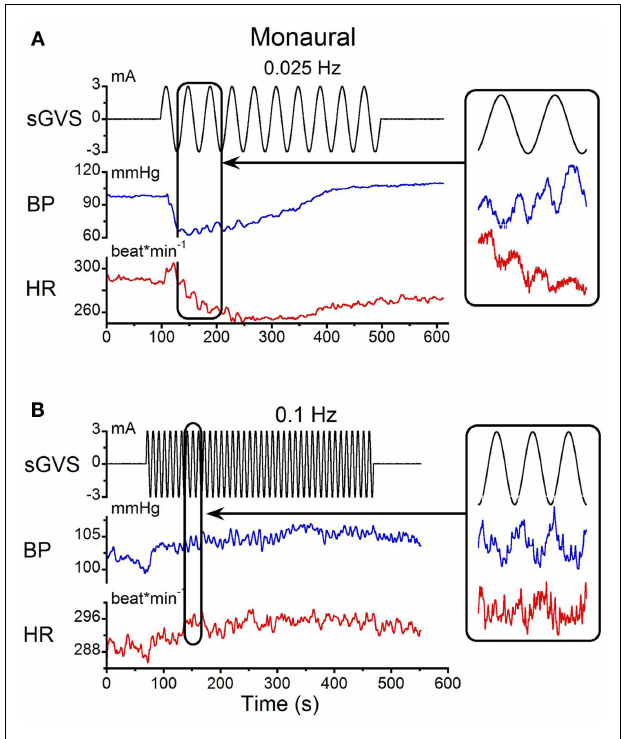
FIGURE 2 | Monaural sGVS induced by 3mA sinusoid at 0.025Hz (A) and 0.1Hz (B) . (A) The 0.025Hz stimulus (black) induced transient decreases in systolic BP (blue) and HR (red).There were two oscillations in BP and HR for each stimulus cycle (expanded trace on right). (B) A higher stimulus frequency (0.1Hz) induced only oscillatory components in systolic BP and HR at the frequency of stimulation (expanded trace on right).